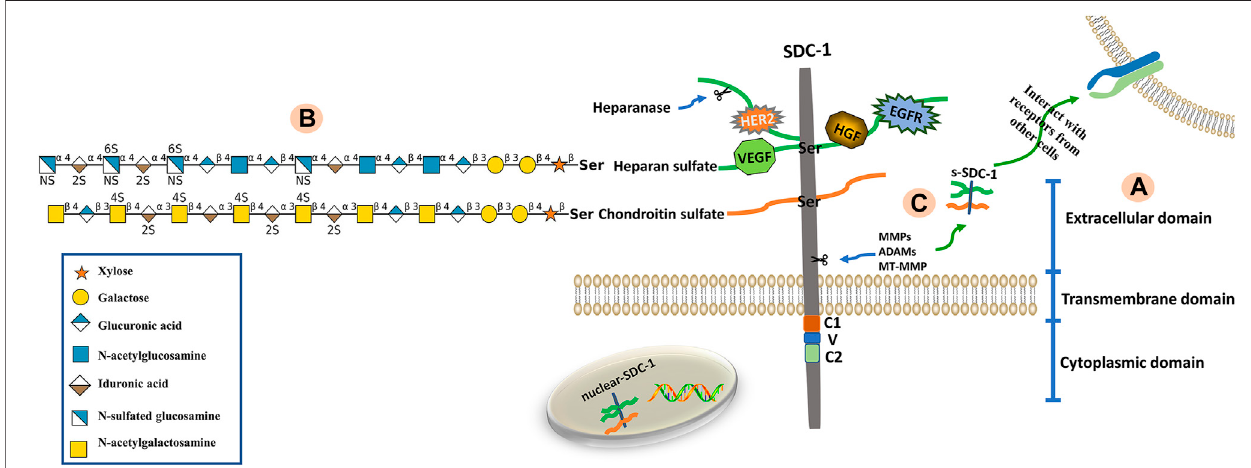
FIGURE1| Structure ofSDC-1. (A) TheSDC-1coreprotein consists ofthree major(extracellular,transmembraneand cytoplasmic)domains. (B) Theextracellular domain is bound via glycosaminoglycan (heparan sulfate, HS; chondroitin sulfate, CS) chains. The HS and CS chains are composed of repeating disaccharide units (glycanstructuresarerepresentedaccordingtotheSymbolNomenclatureforGlycans(SNFG)(Chengetal.,2017))linkedtocoreproteinserineresidues.Growthfactors and receptors (e.g., HER2, VEGF, HGF and EGFR) bind to HS chains, which can be fragmented by heparanase. (C) The extracellular domain of SDC-1 is cleaved by sheddases (e.g., MMPs, ADAMs, MT-MMP), a phenomenon known as shedding. This results in the release of attached glycosaminoglycan chains as well as any bound ligands from the cell surface into the extracellular